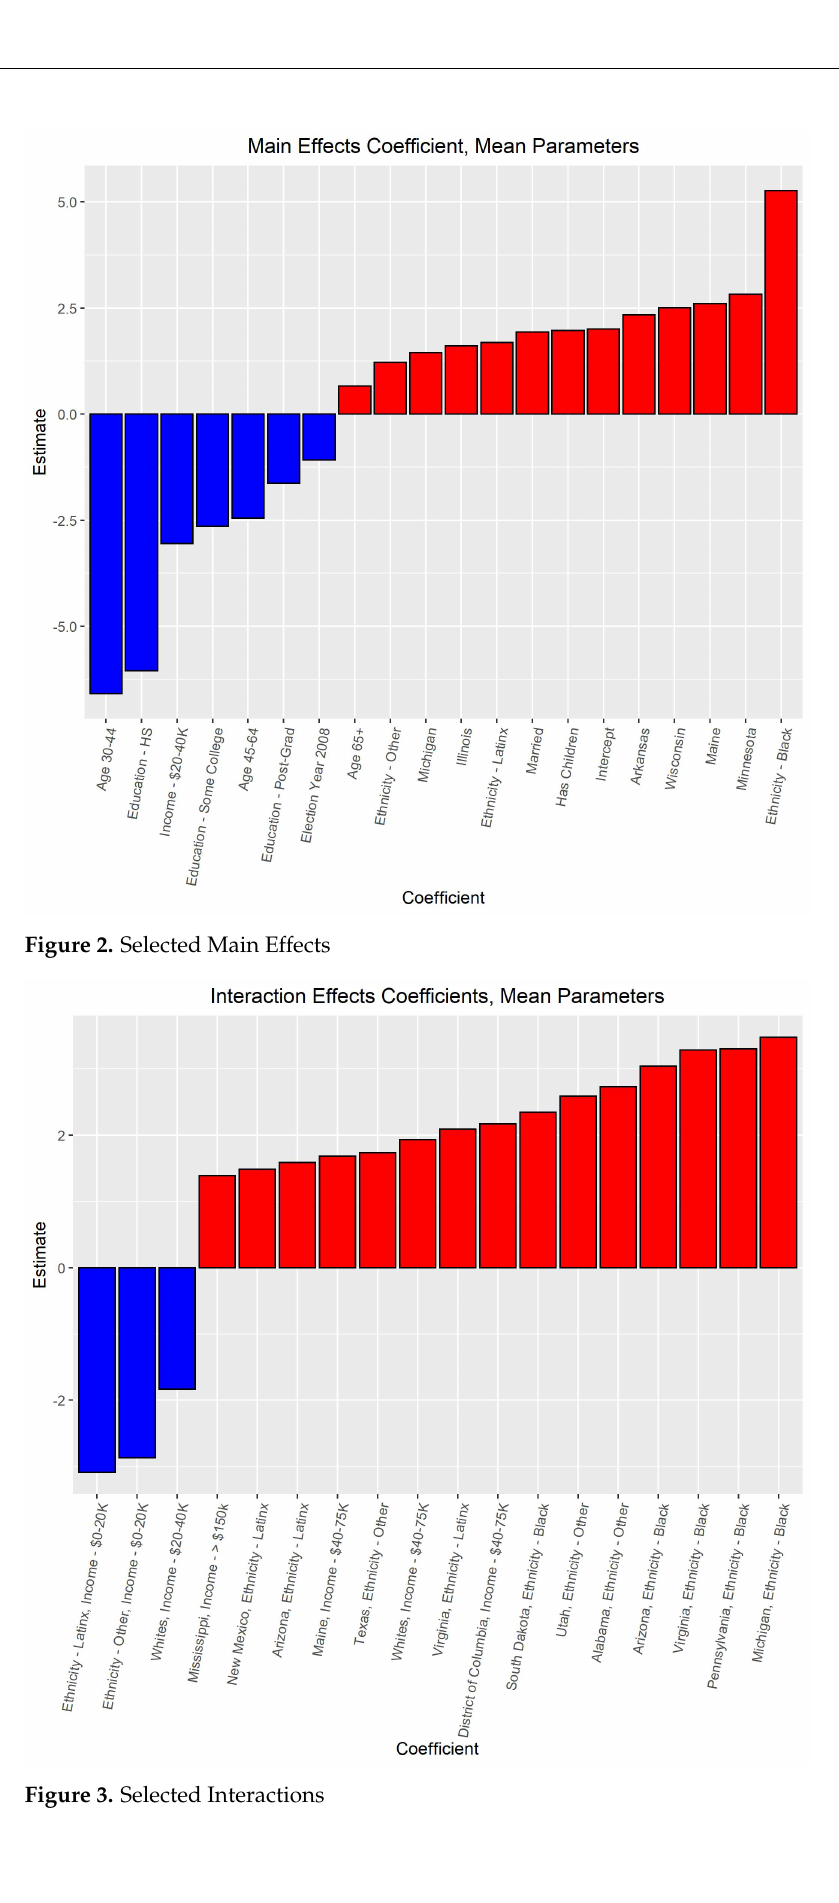
Figure 3. Selected